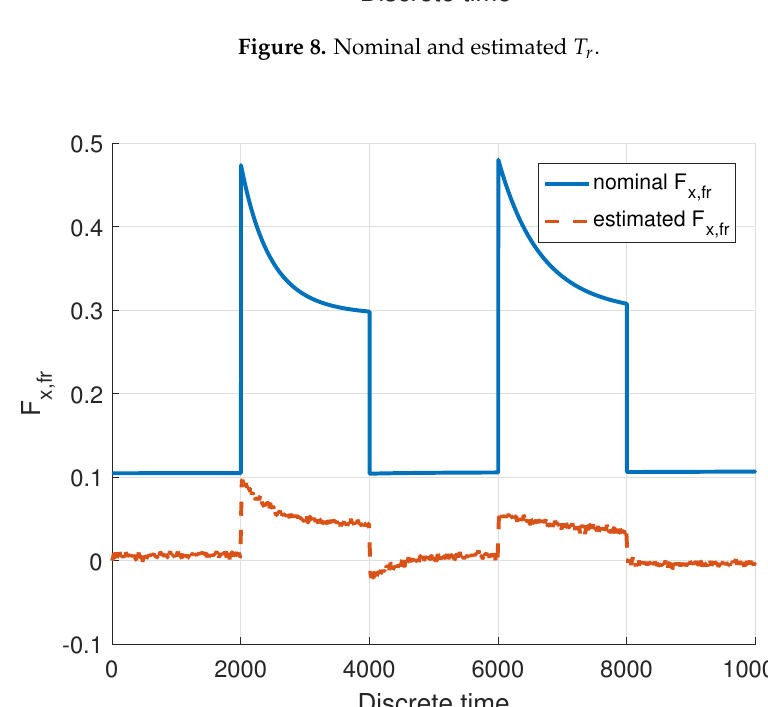
Figure 9. Estimate of F x , fr with the descriptor-LPV (Linear Parameter-Varying) approach (dashed